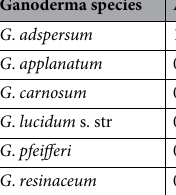
Table 3. The list of the used values of output linguistic